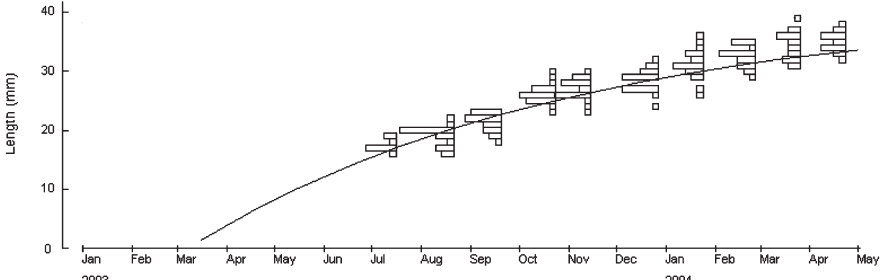
Fig. 6. – Von Bertalanffy growth curve fitted to monthly length frequency distributions of a single Buenia affinis